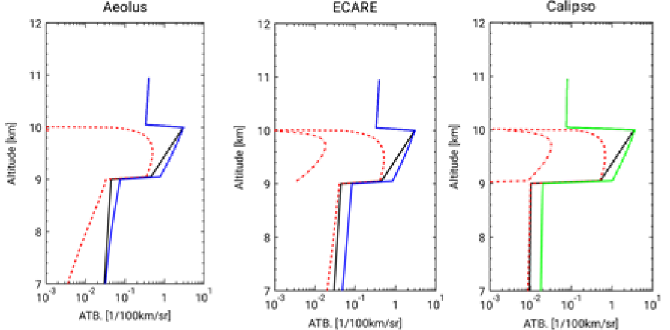
Figure 2: Simulated relative (total Ray+Mie) attenuated backscatter profiles corresponding to an idealized cirrus cloud with an optical thickness of 1 and an effective particle size of 20 microns. The Black lines correspond to the single-scatter only return, the Red lines show the 2nd and 3rd order scattering respectively (3rd order return for the Aeolus case is too small to be shown) and the Blue and Green lines represent the total single scattering (SS)+multiple scattering (MS) returns.